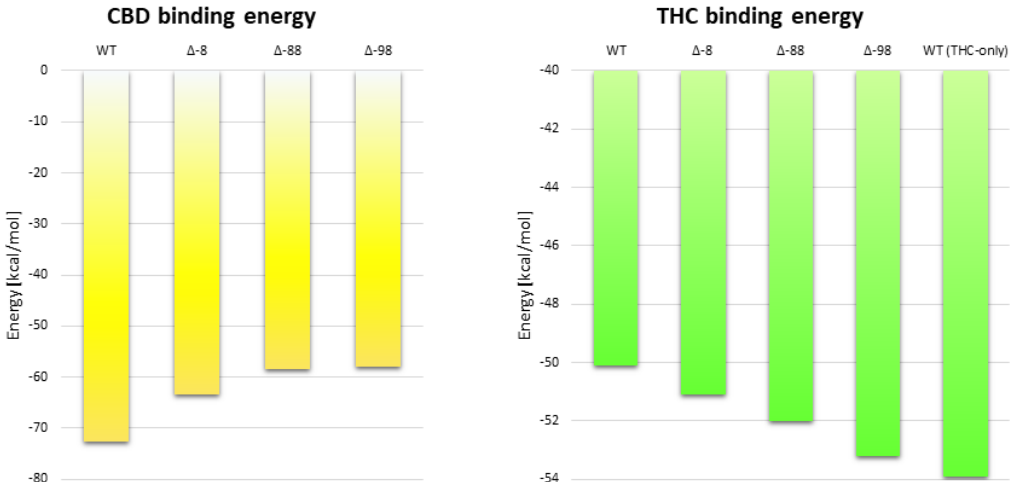
Figure 12. Comparison of ligand binding energies for different mutants of CB 1 R with truncated N-terminus and a wild-type receptor for CBD-THC complex. The energies of CBD binding to the allosteric site ( left ) are shown in yellow while the energies of THC binding to the orthosteric site ( right ) are shown in green. All reported binding energies are the average values obtained from several (5 for WT, and 2 for mutants) 1 µ s long MD simulations and they were performed for CBD-THC complex (except for the last rectangle). ∆ -8 (deletion of 1–8 residues), ∆ -88 (deletion of 1–88 residues) and ∆ -98 (deletion of 1–98 residues).